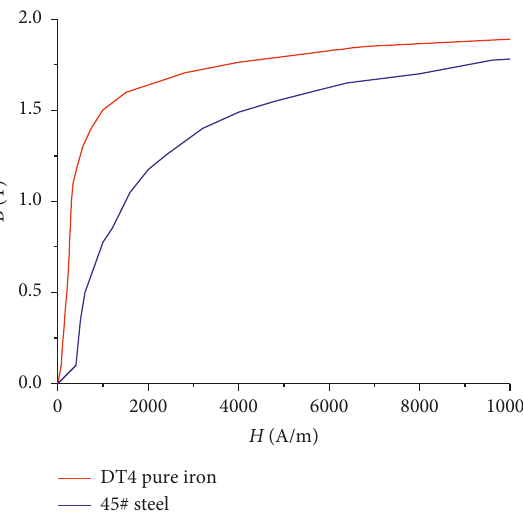
Figure 6: Relationship between τ